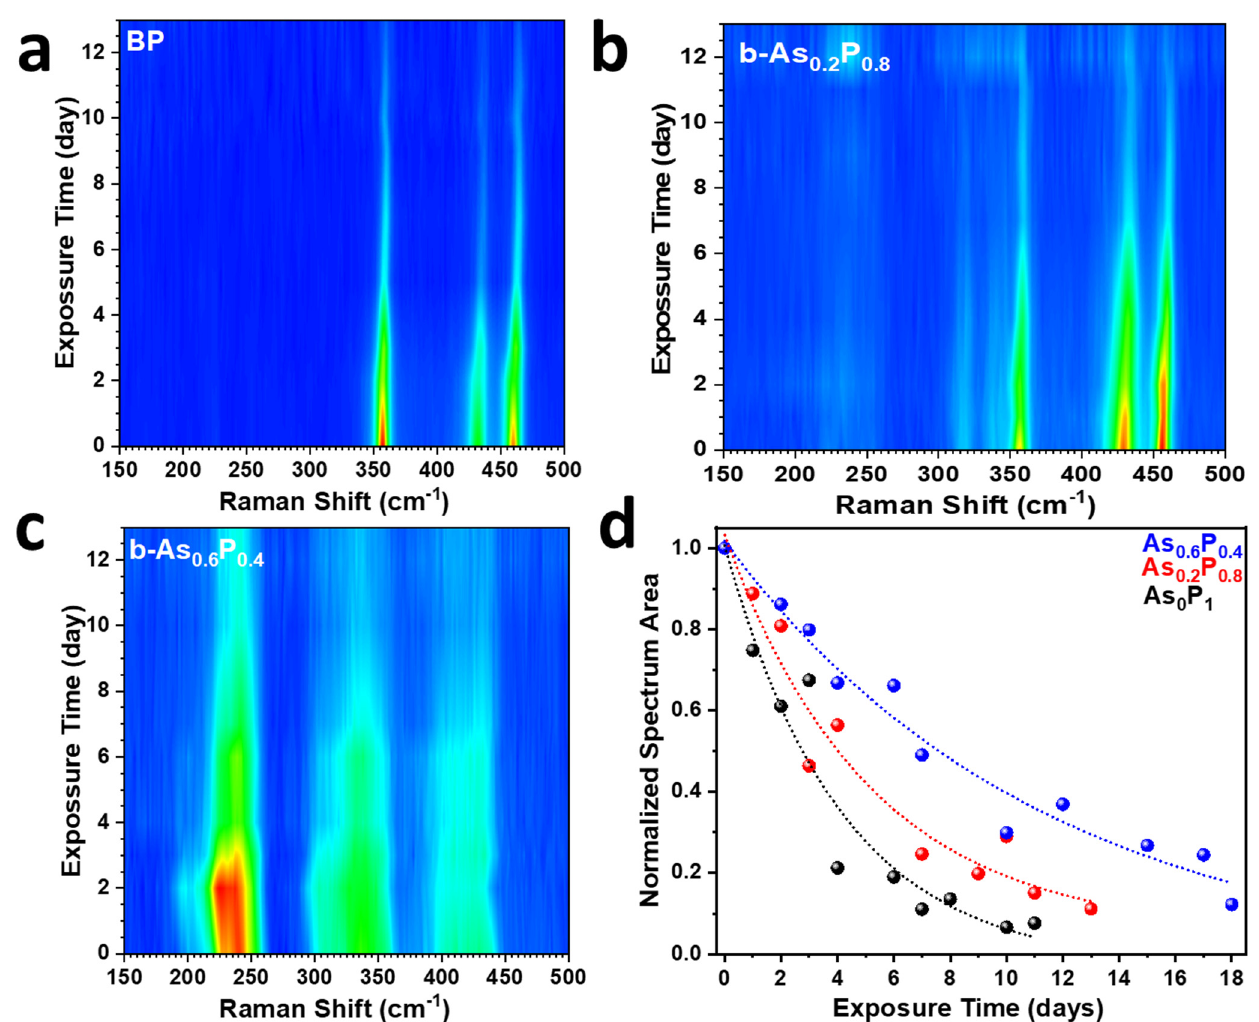
Figure 3. Results derived from Raman spectroscopy. ( a – c ) Degradation maps showing time evolution of Raman spectra upon exposure to ambient environment for BP, As 0.2 P 0.8 , and As 0.6 P 0.4 , respectively. ( d ) The total Raman intensity as a function of exposure time for BP (As 0 P 1 ), As 0.2 P 0.8 and As 0.6 P 0.4 . The initial (t = 0) total intensity for all three samples was normalized to 1.